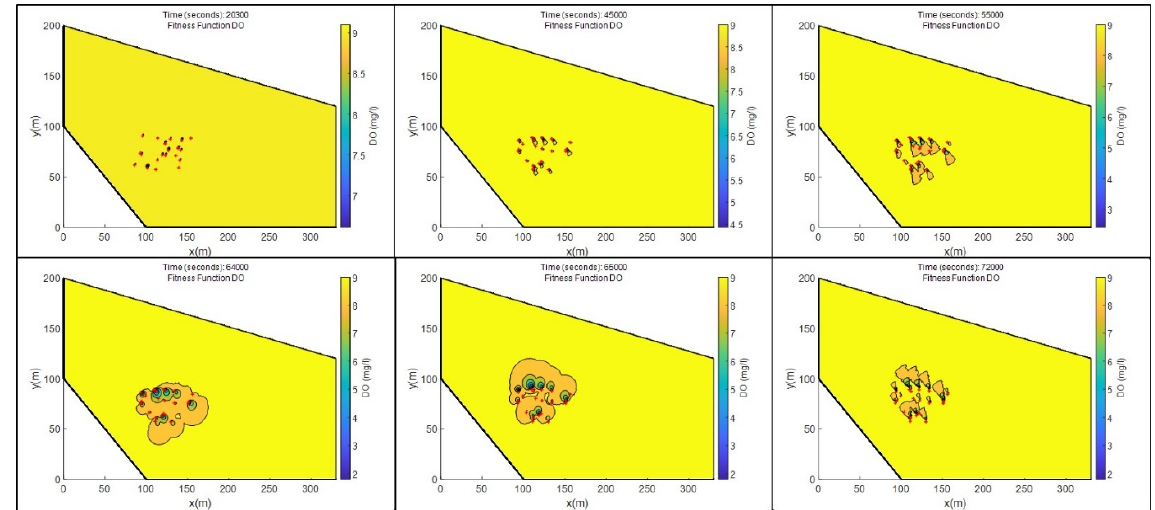
Figure 9. Example development of submarine groundwater discharge (SGD) plumes over time.